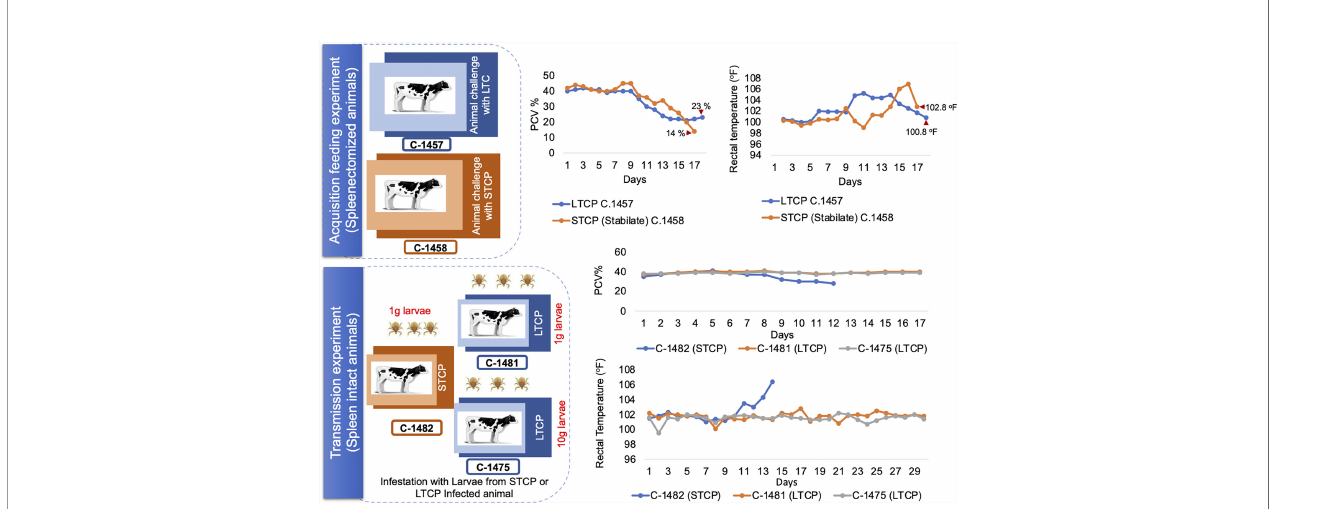
FIGURE 4 | Schematic illustration and clinical parameters derived from the tick transmission experiments. The upper panel illustrate the acquisition feeding phase of the experiment, which was performed using splenectomized animals. Changes in the PCV and rectal temperature are illustrated on the right side of the panel. The lower panel illustrate the transmission phase of the experiment, performed on spleen intact animals. Changes in the PCV and rectal temperature are illustrated on the right side of the panel. Calf C-1482 infected with STC parasites via infected larvae was euthanized due to acute clinical signs at day 14 post application of control B. bovis infected